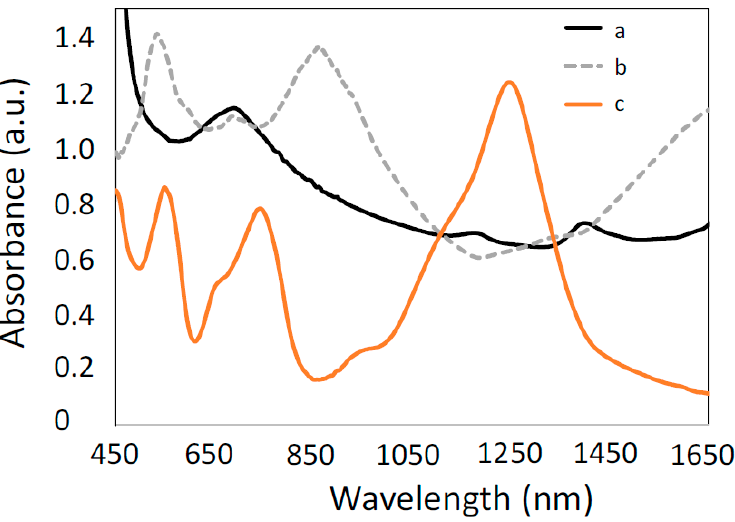
Figure 10. Absorption peaks observed from the device having different coating thickness (70 nm, 300 nm, and 690 nm). Reprinted with permission from [114]. (b) 300 nm, and (c) 690 nm). Reprinted with permission from